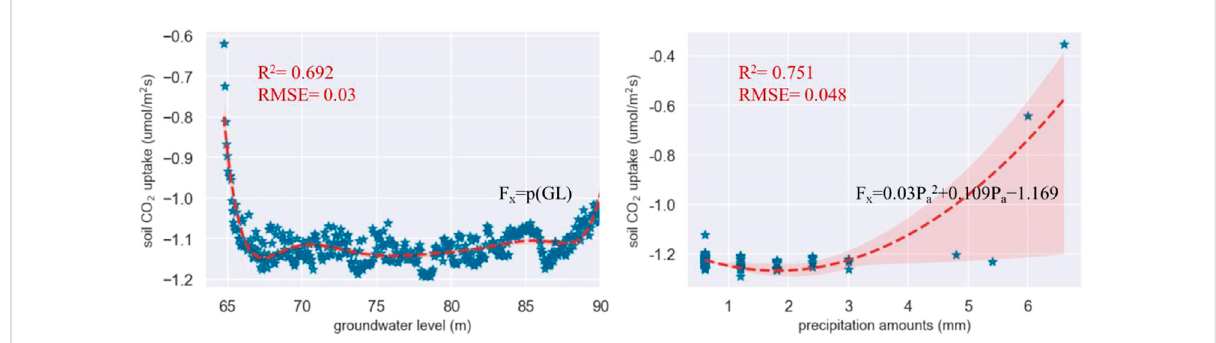
FIGURE 7 Complicated in fl uencesofgroundwaterlevel(GL)andprecipitationamounts(P a )onsoilCO 2 uptake(F x ).Note:pisaneighth-orderpolynomial. Thecoef fi cientsofthe8th,7th,6th,5th,4th,3rd,2nd,and1stordertermsare2.658e − 09, − 1.66e − 06,0.0045,0.0705,6.853, − 425.8,1.652e+04,and 3.655e+05, respectively. The constant is 3.535e+06.